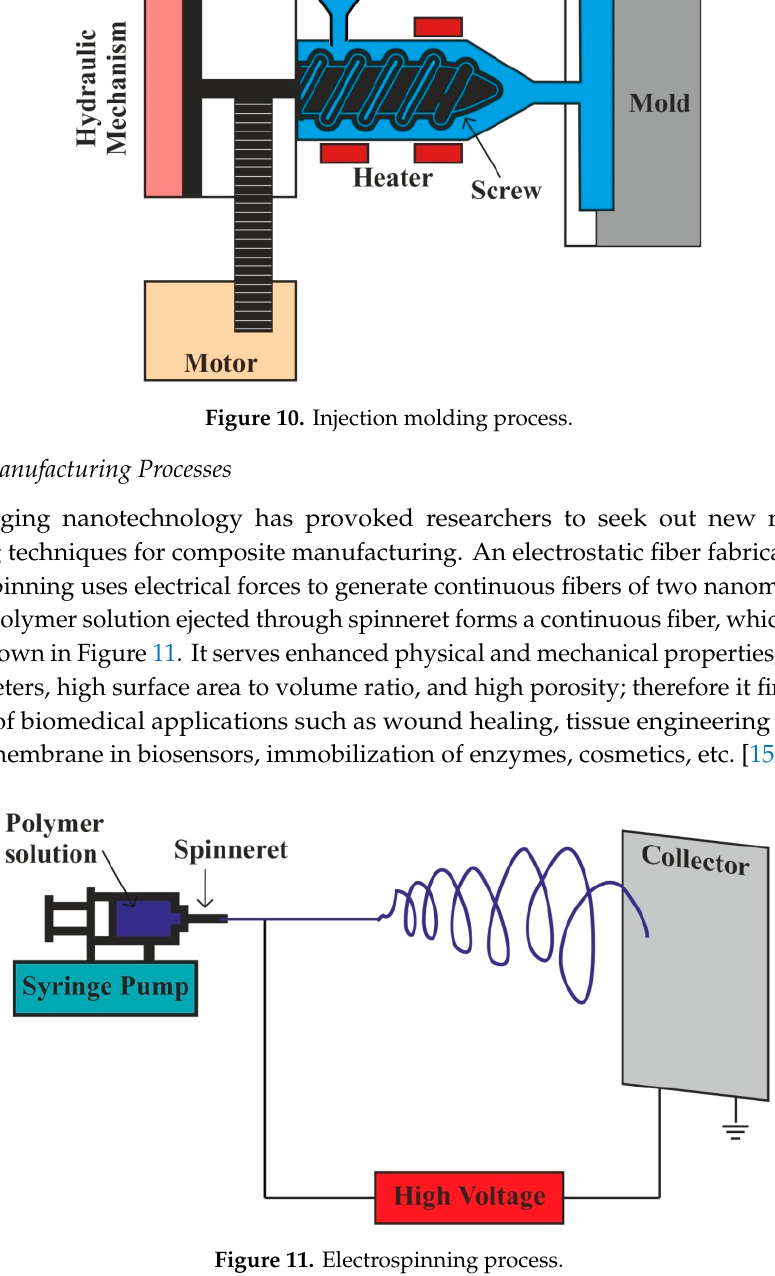
Figure 11. Electrospinning process.